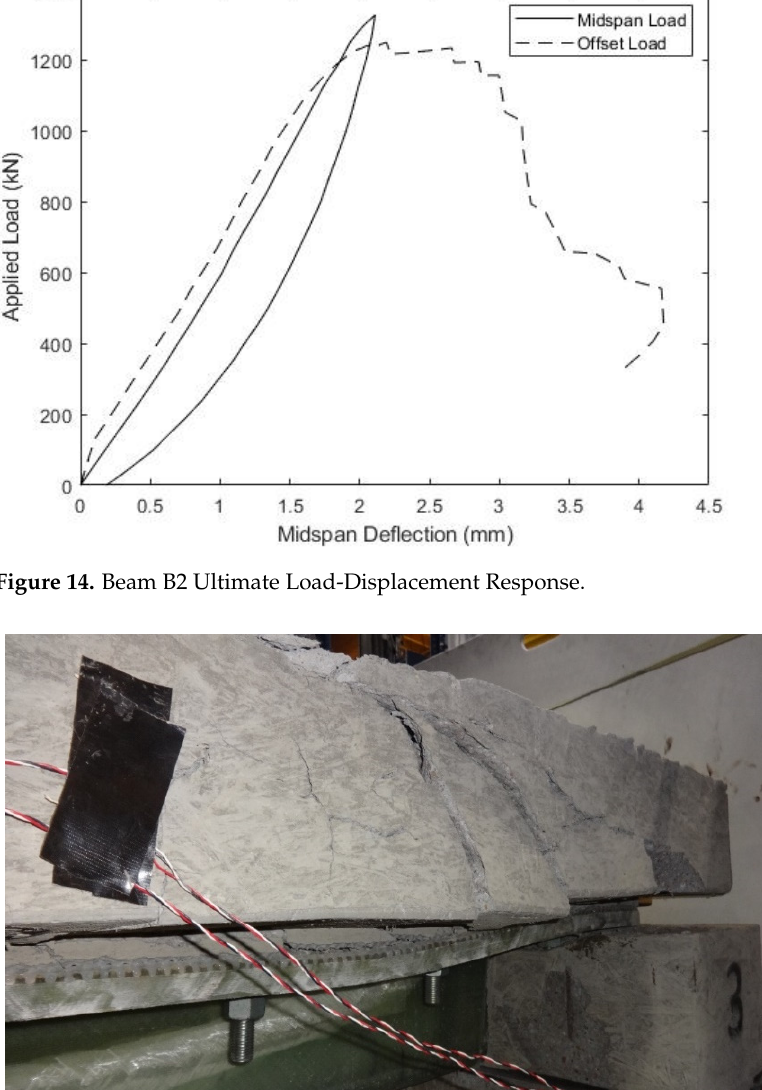
Figure 13. Beam B1 Ultimate Load-Displacement Response.